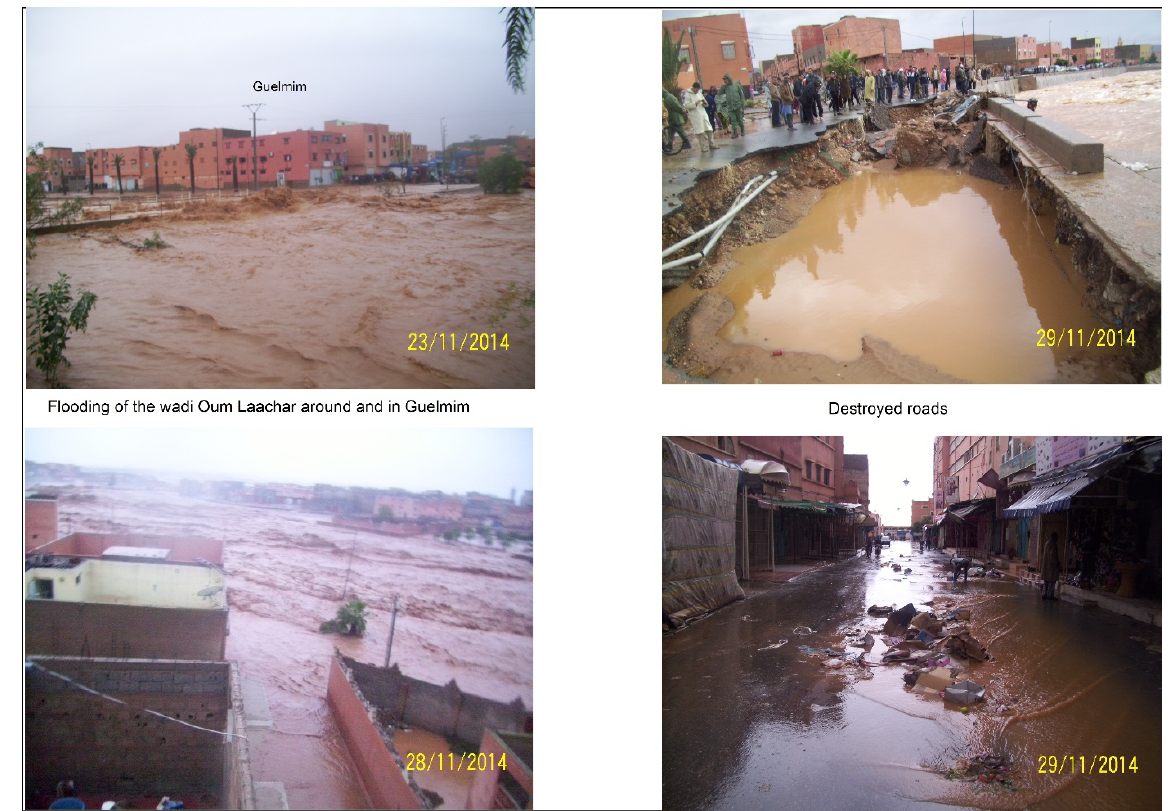
Figure 2. Flooding of the Wadi Oum Laachar near and within in the city of Guelmim. The bridge is partially submerged by the waters of the river and the road was destroyed by floods. (Images: Abdessamad Charif, November